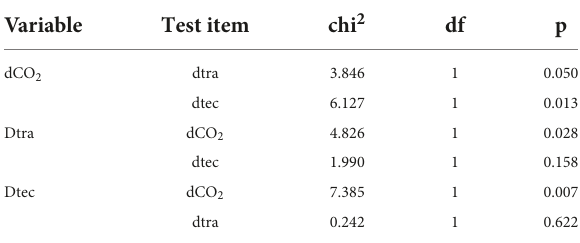
TABLE 2 Unit root test results of panel data. TABLE 4 Granger causality